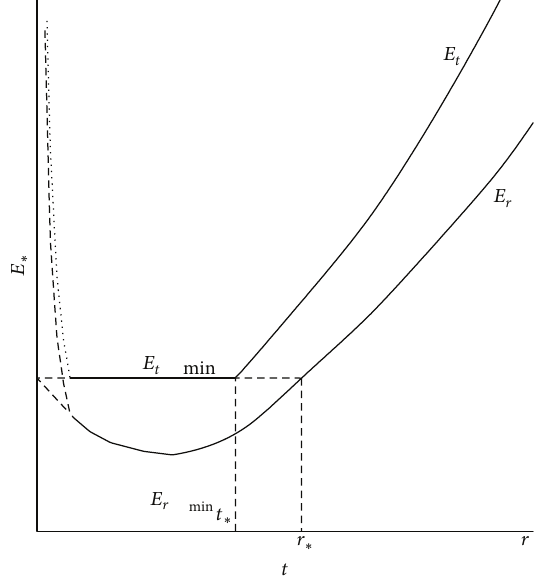
Figure 18: Spatial and time components of critical initiation energy on spatial-time parameters of